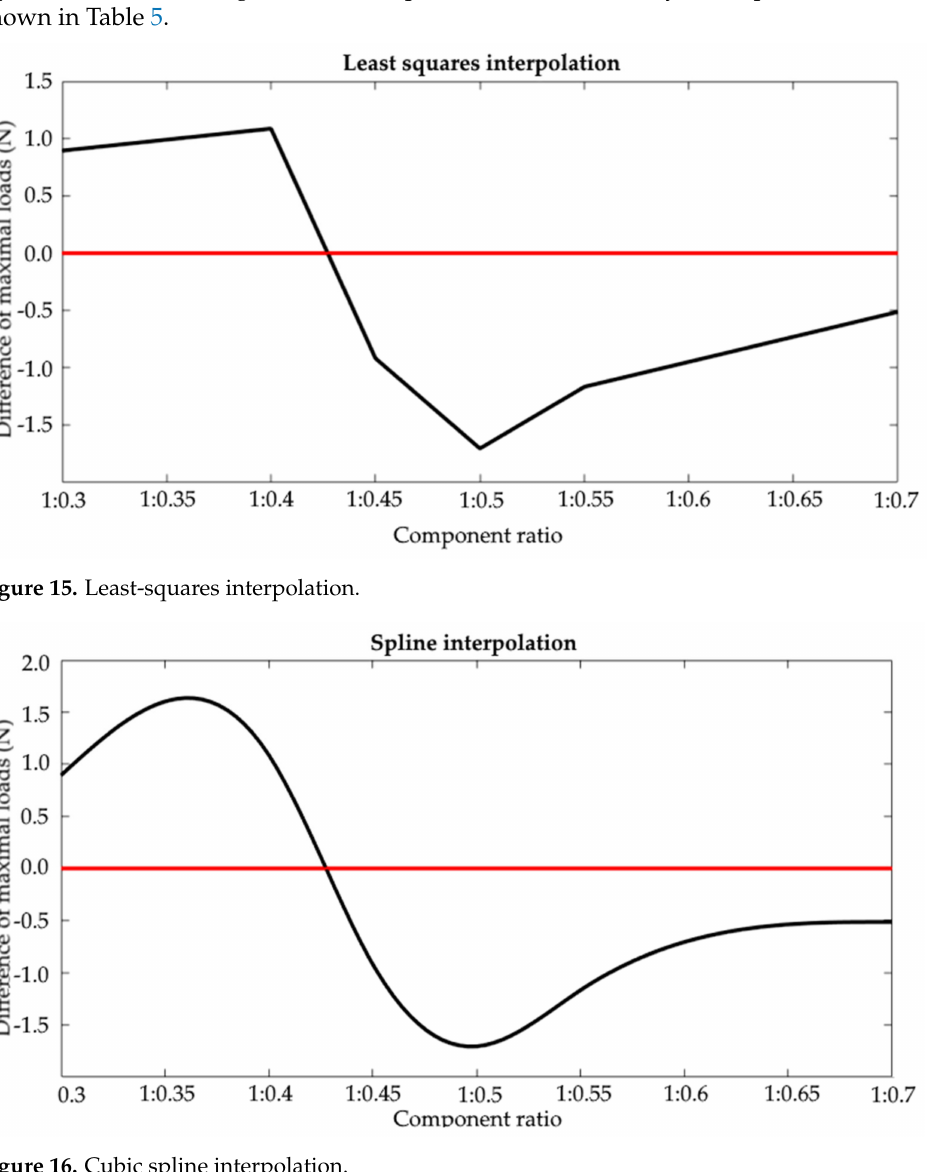
Figure 16. Cubic spline interpolation. Table 5. Independent test and forecast